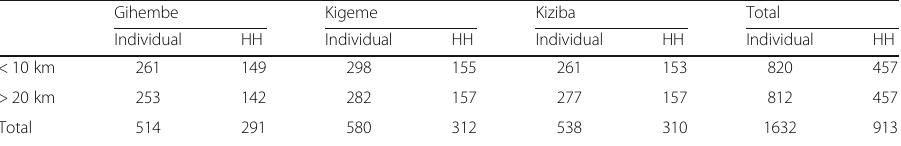
Table 2 Sample in host communities, by distance to the nearest camp